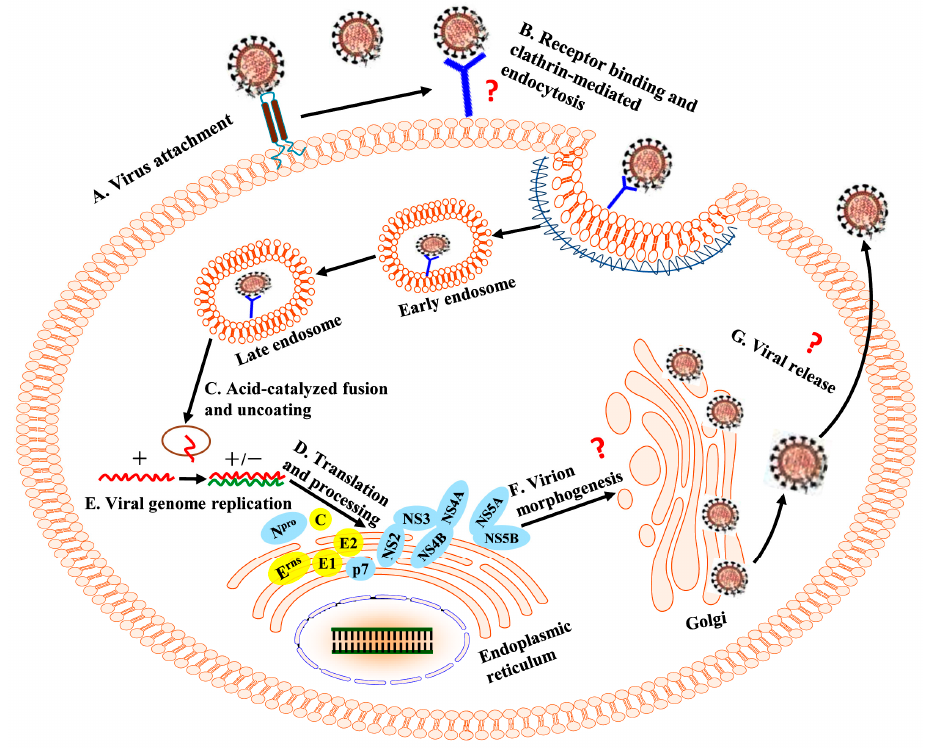
Figure 3. Schematic diagram of the CSFV life cycle. ( A ) Interactions between E rns and host cellular heparan sulfate (HS) and/or laminin receptor (LamR) mediate virus attachment. ( B ) Virus binds to an unknown entry receptor(s) and triggers clathrin-mediated endocytosis. ( C ) Low pH facilitates viral envelope and membrane fusion. ( D ) Translation and processing of viral proteins. ( E ) Viral genome replication. ( F ) Virion morphogenesis harbors an unknown strategy. ( G ) Mature virions are released from the cell via an unknown secretory pathway. +, positive-strand genomic RNA; +/ − , positive- and negative-strand replicative intermediate.